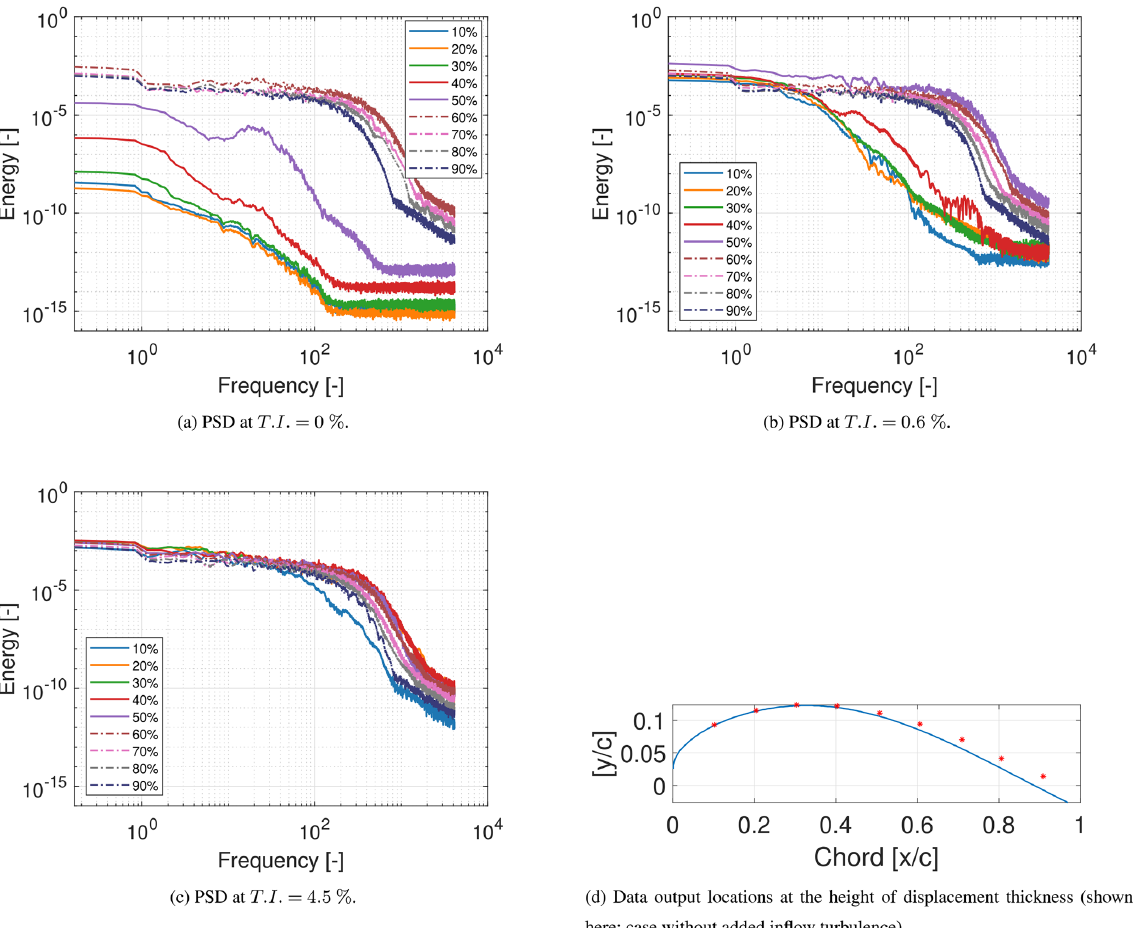
Figure 21. Power spectral density of the turbulent kinetic energy at different T.I.s determined at the height of the displacement thickness in the mid-span at every 10%